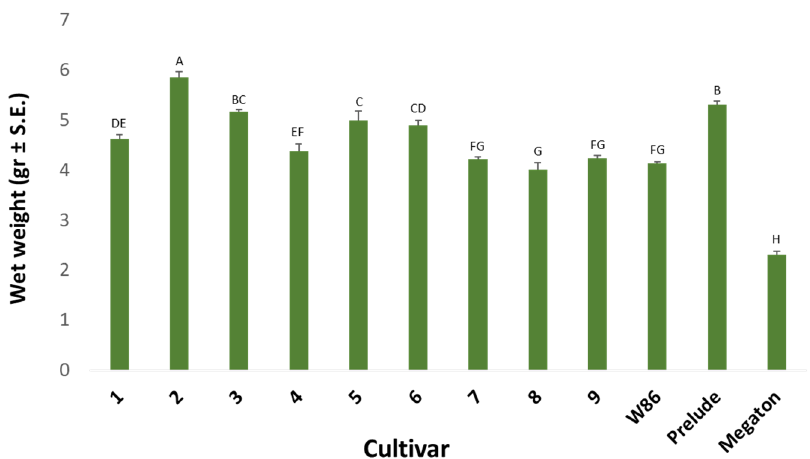
Figure 2. Seedlings’ fresh biomass at day six in the in vitro seed test. The experiment is described in Figure 1. Vertical upper bars represent the standard error of the mean of 10 repeats (Petri dishes containing 10 seeds). Different letters above the bars represent a significant difference ( p < 0.05) in an analysis of variance (ANOVA) assay.